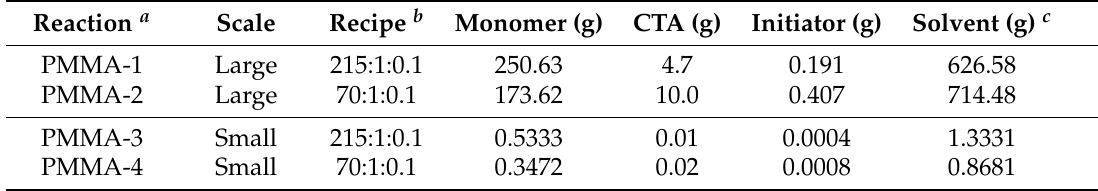
Table 4. Reaction conditions for all polymerization reactions.